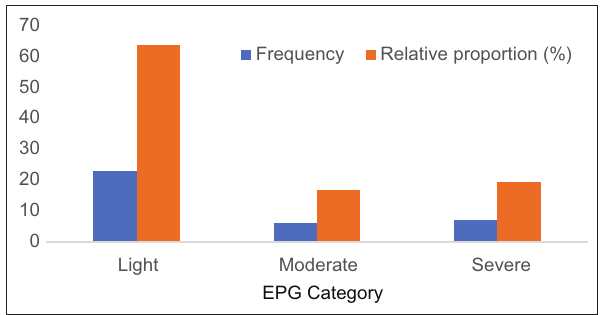
Figure-1: Frequency and relative proportion of egg per gram categories in infected donkeys (n=36).